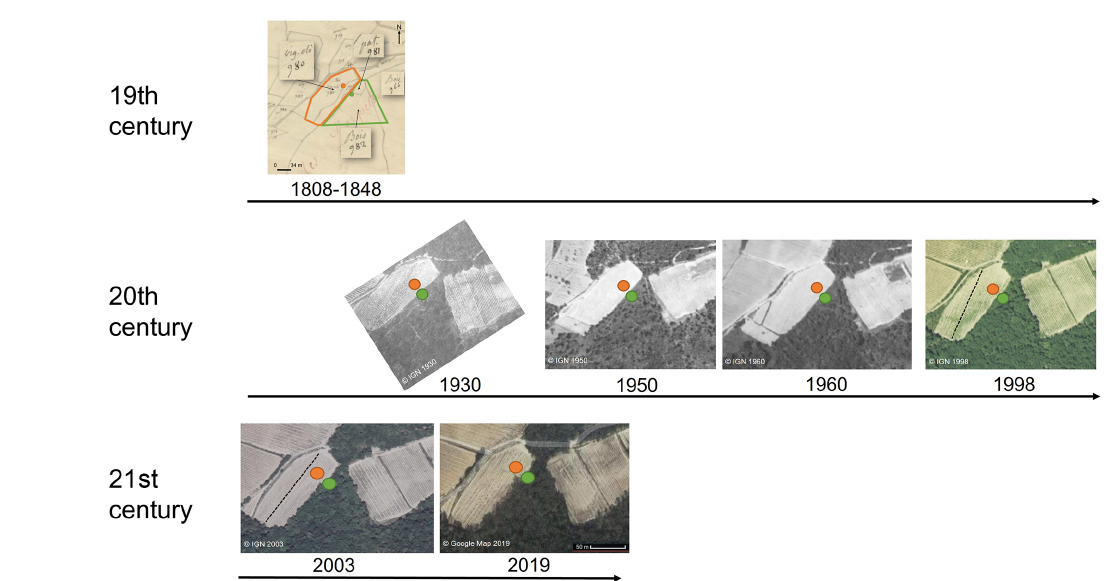
Figure A3. History of land use at the Les Brugassières site from the 19th century to the present day through the study of old maps and aerial photos. The boundaries of the forest (green) and vineyard (orange) plots were shown on the Napoleonic land register (1808–1848; https://archives.var.fr, last access: 12 November 2020). All aerial photos from the 20th century to the present day were from the IGN Remonter le temps website (https://remonterletemps.ign.fr/, last access: 12 November 2020). The pit locations are indicated by orange and green circles.